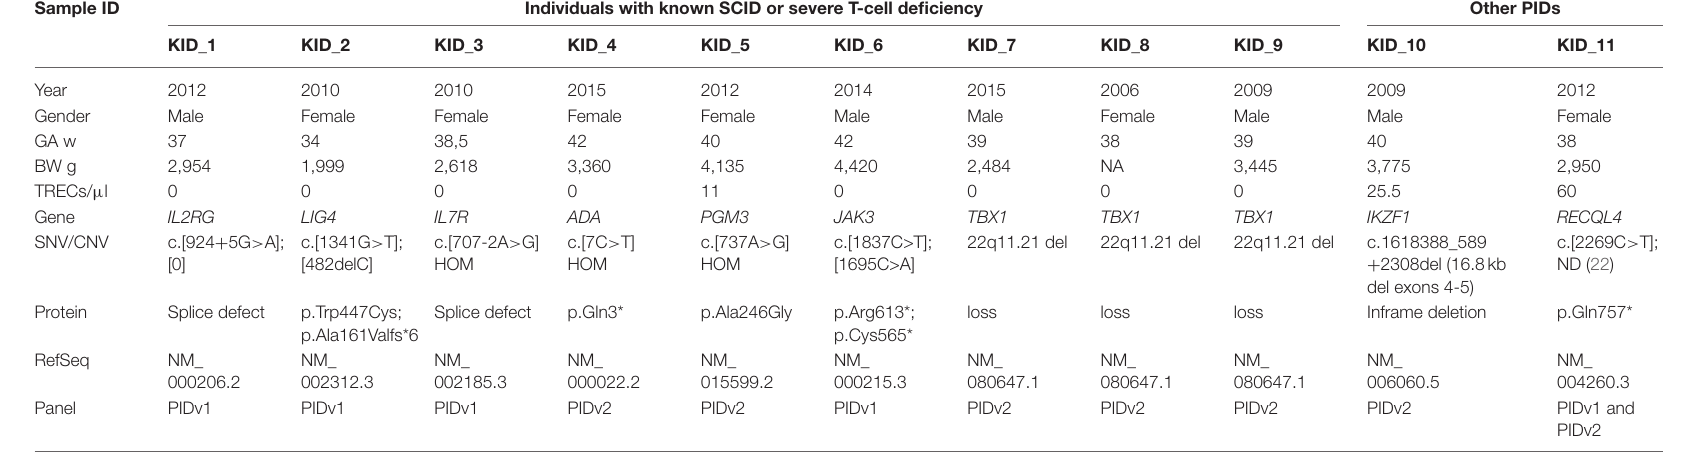
TABLE 3 | Retrospective TRECs and NGS testing in known PIDs using DNA from the original newborn screening DBS. Sample ID